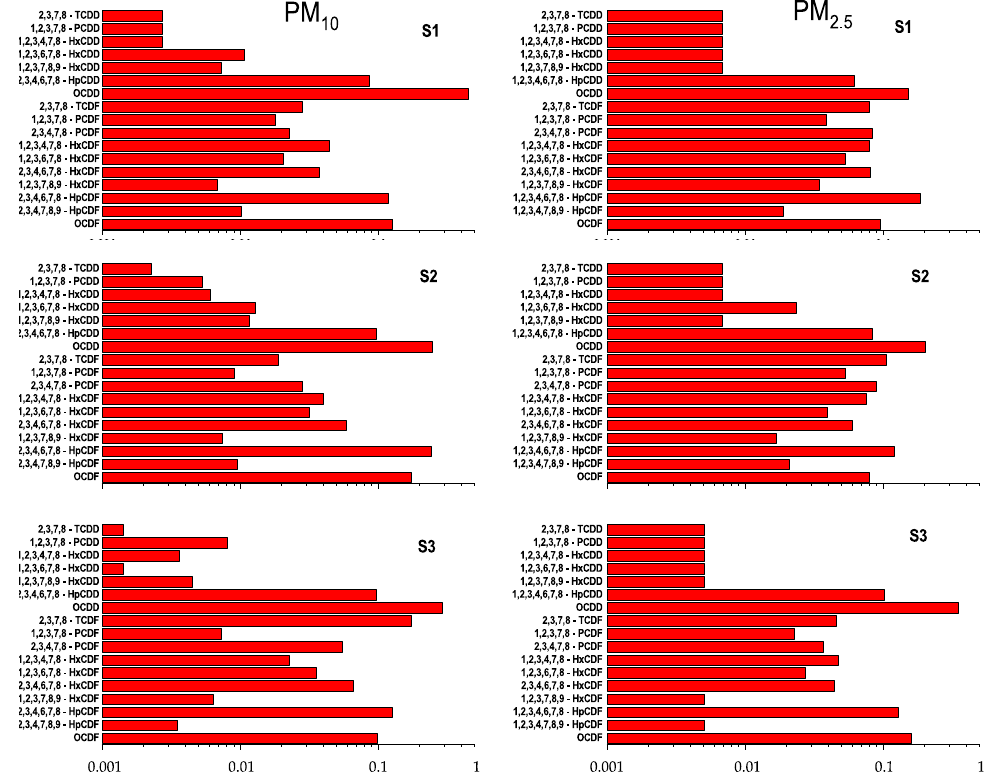
Figure 9. PCDD/F profiles in the UB site during spring sampling—the predominance of Octachlorodibenzodioxin (OCDD) and Octachlorodibenzofuran (OCDF) congeners is consistent with those reported by scientific literature in emissions from coal-fired power plant. From the scientific literature [68–72] a similar profile is highlighted for PCDD/F emitted by large coal combustion plants. The PM 10 and PM 2.5 profiles at sector #1 are similar only in the autumn period, whereas they are different in the other two periods. The profiles of sector #2 of PM 2.5 show greater variability, between periods and between congeners contributions. The PM 10 profiles at sector #2 differ from those of PM 2.5 and show differences among periods in terms of detected congeners and their relative contribution. The PCDD/Fs profile sampled at sector #3 in PM 2.5 shows a wide variability